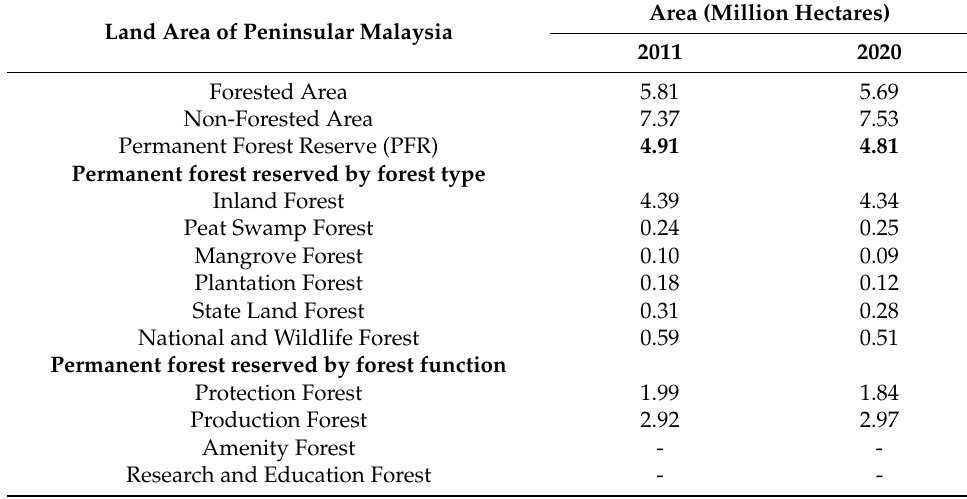
Table 2. Forest statistics collected by the Department of Forestry of Peninsular Malaysia for 2011 and